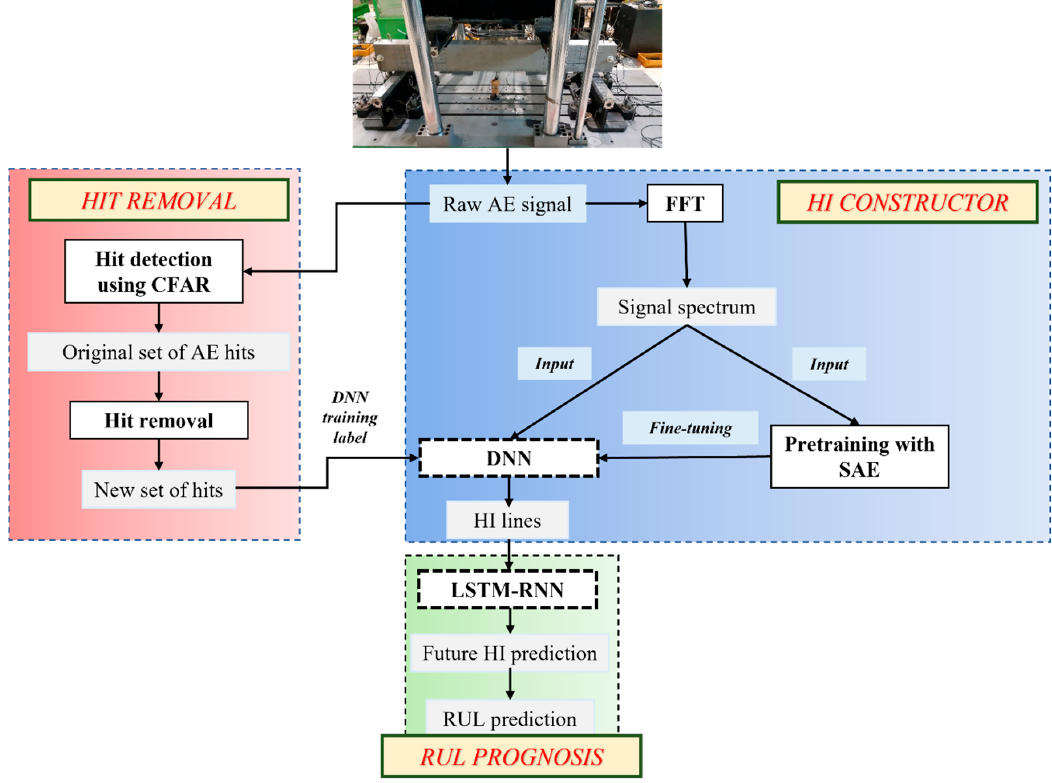
Figure 3. Flowchart of the proposed scheme.